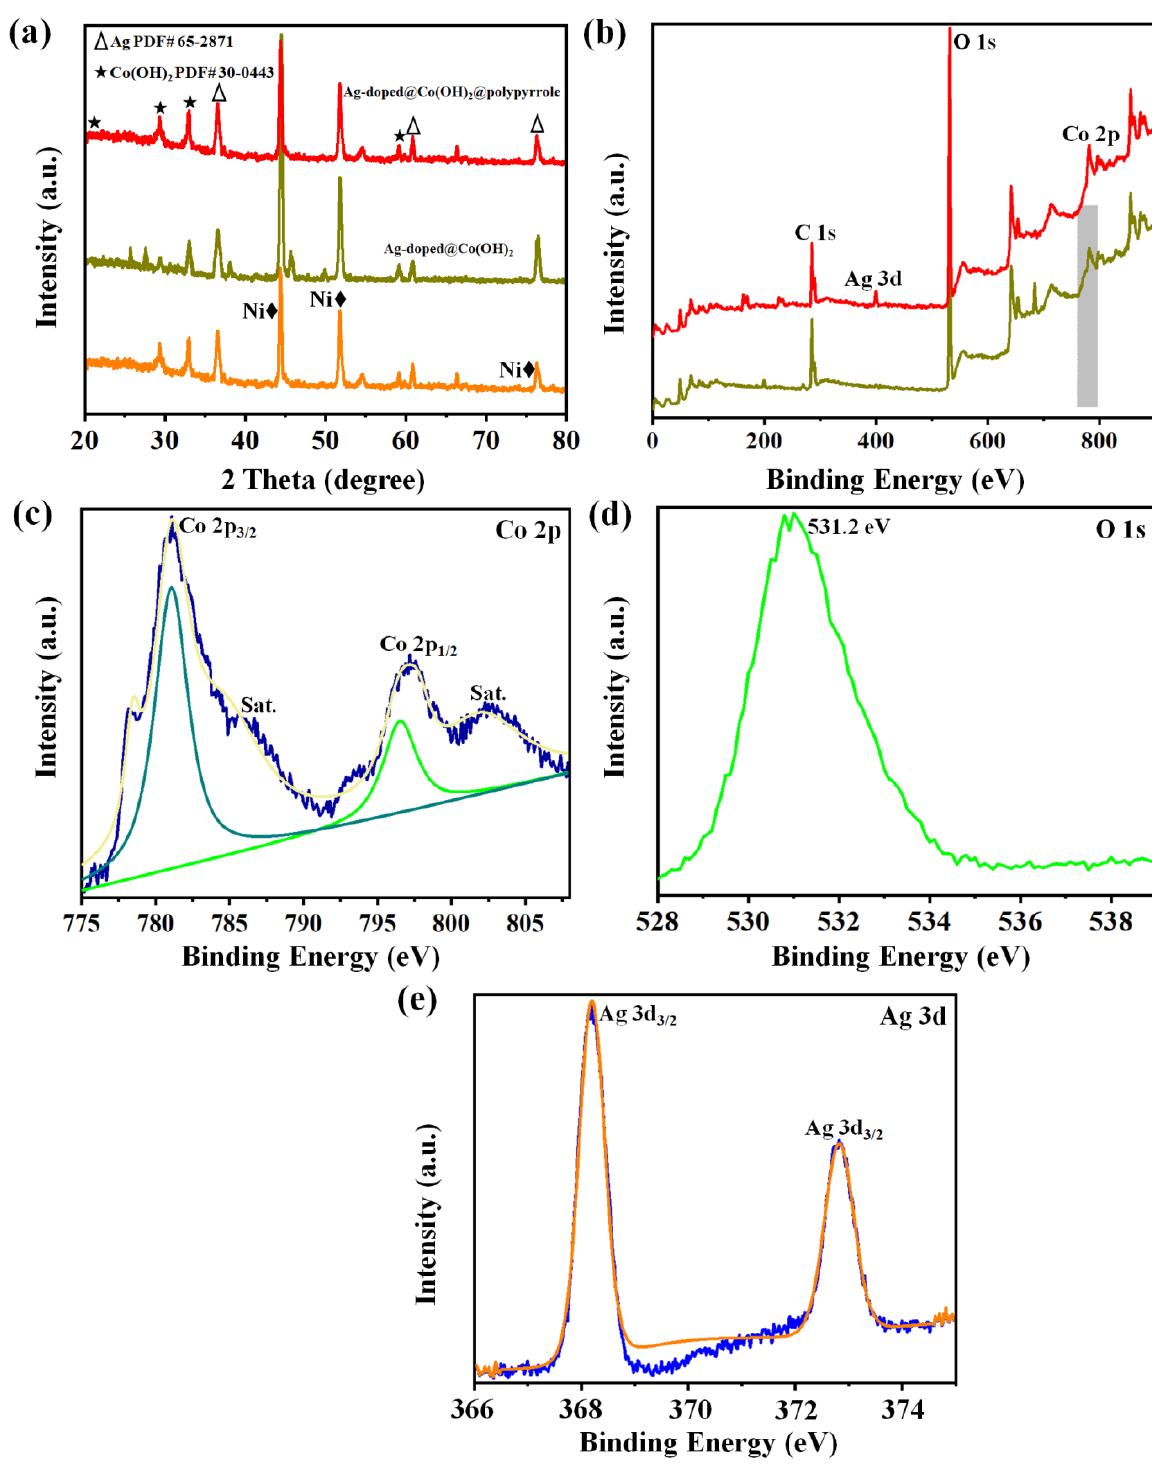
Figure 4. XRD patterns for the electrode materials ( a ); XPS survey spectrum ( b ) and XPS spectra of Co 2p ( c ), O 1 s ( d ), and Ag 3d ( e ) of the Ag-doped@Co(OH) 2 @polypyrrole NSs.